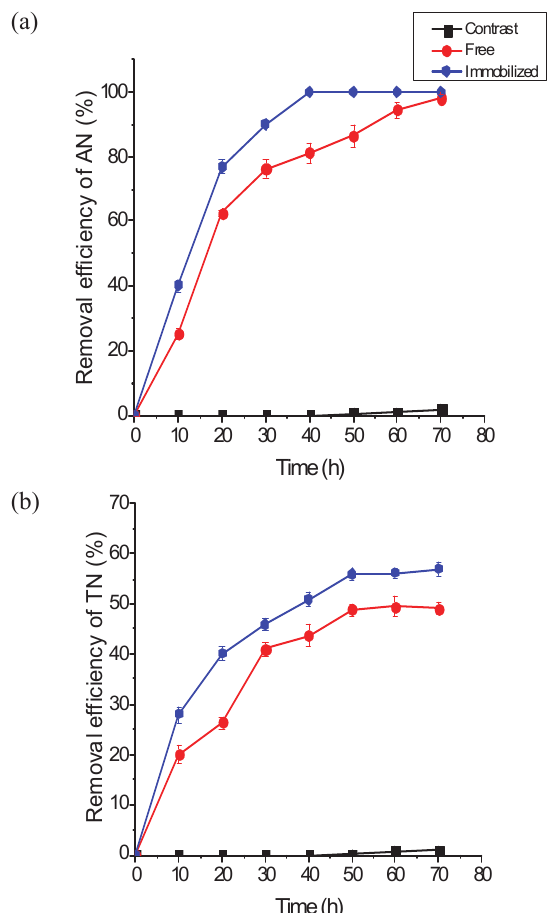
Fig. 4 – Effect of treatment time on AN removal (a) and TN removal